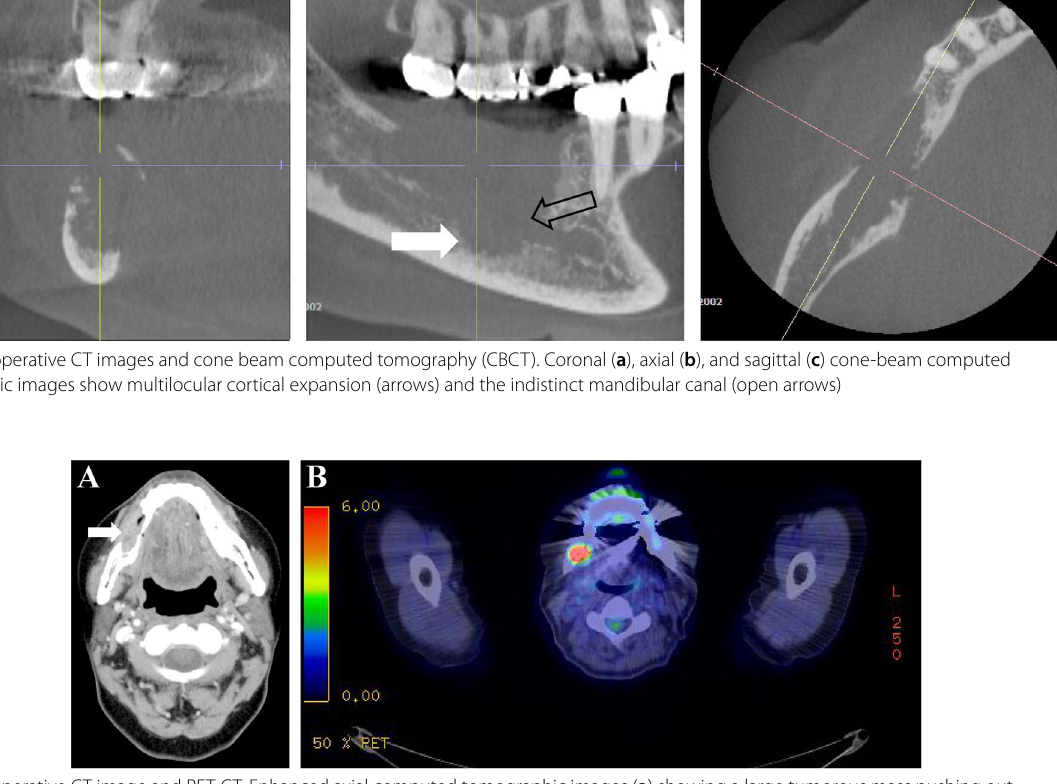
Fig. 4 Preoperative CT image and PET-CT. Enhanced axial computed tomographic images ( a ) showing a large tumorous mass pushing out towards adjacent soft tissue bucco-lingually. Inside the tumor, necrotic foci (arrows) can be observed. PET-CT ( b ) showing a mass protruding on the bucco-lingual side in the #45 and #46 region with FDG accumulation and SUVmax of 22.73